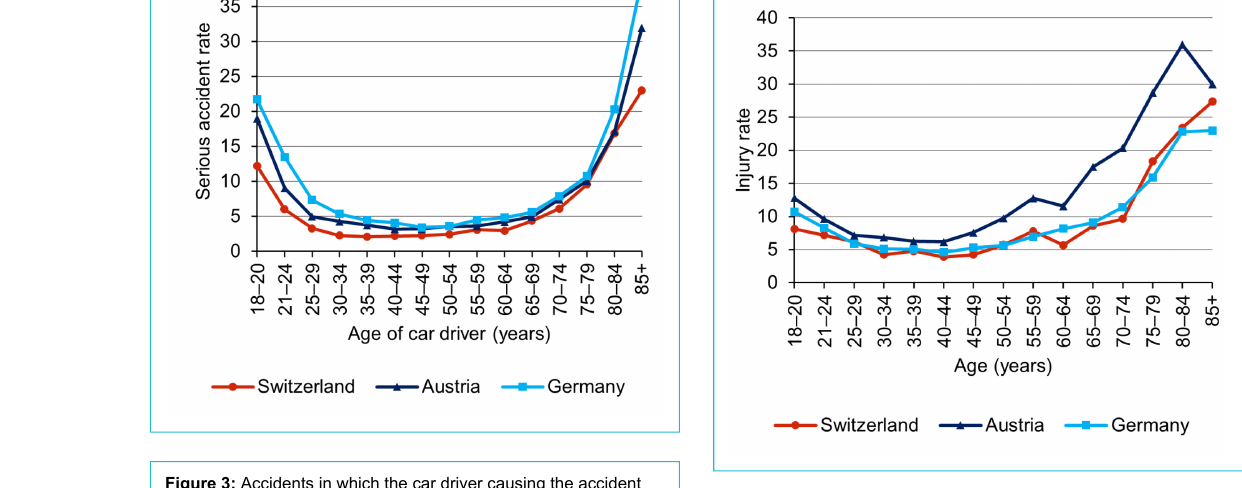
Figure 3: Accidents in which the car driver causing the accident was seriously or fatally injured, per 100 million person kilometres driven, by age group of car driver and country (analysis 1a). The corresponding numerical values including 95% confidence inter- vals can be found in the appendix (table S1).